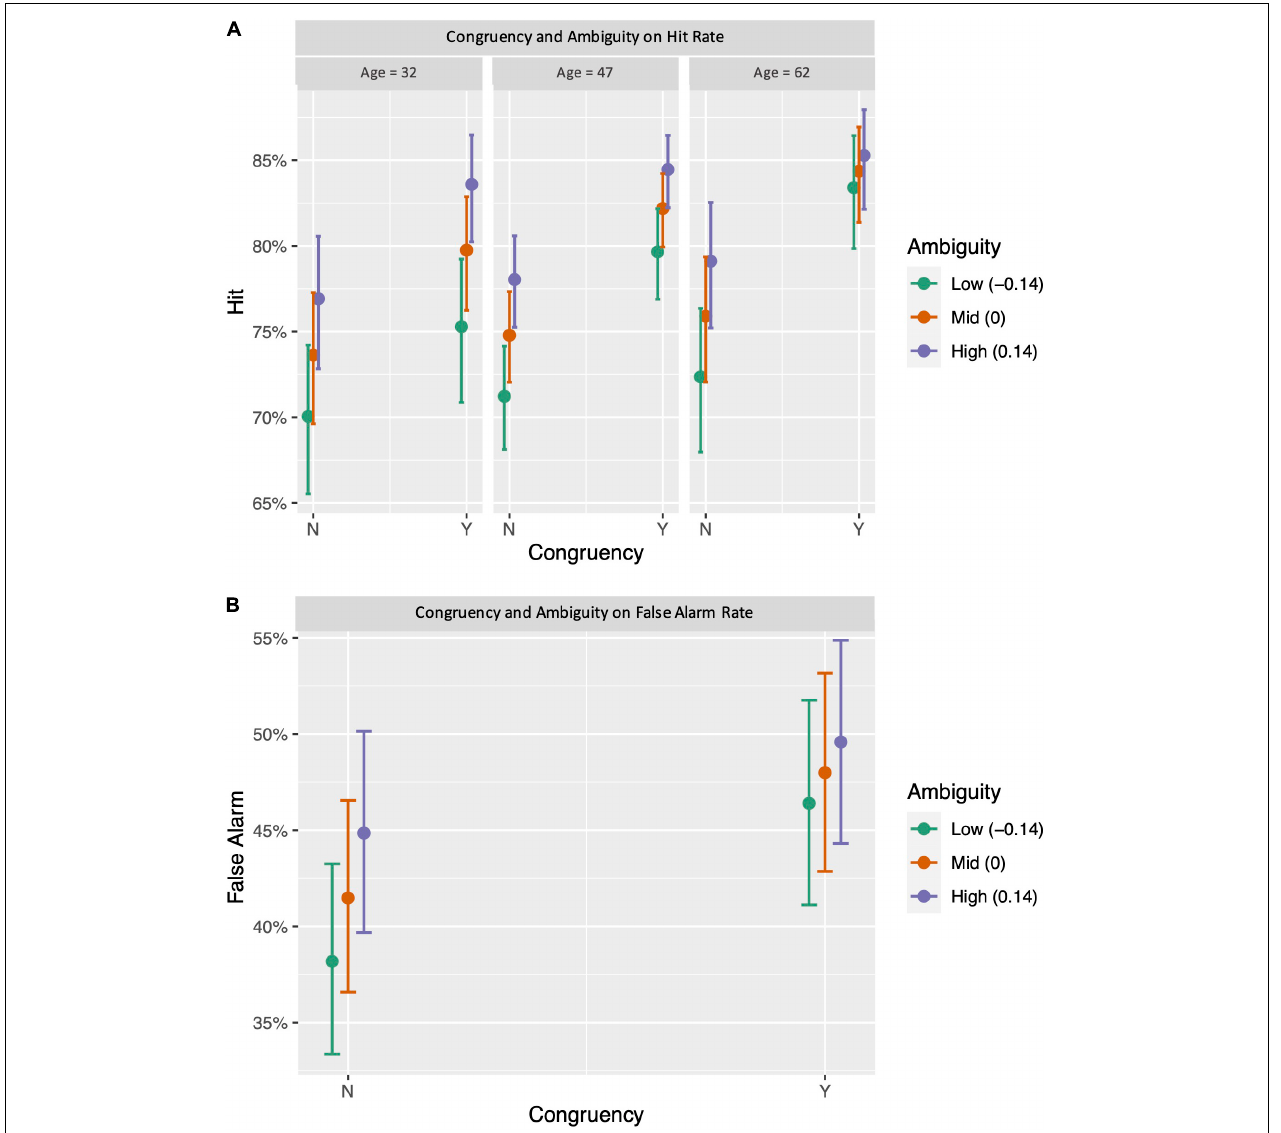
FIGURE 5 | Interactive effects of congruency and ambiguity on memory hit rate and false alarm rate. (A) For hit rate, ambiguity effect diminished for pairs perceived as congruent in people above 58 years old. (B) For false alarm rate, ambiguity only appeared to affect memory for pairs perceived as incongruent. Error bars represent 95% confidence